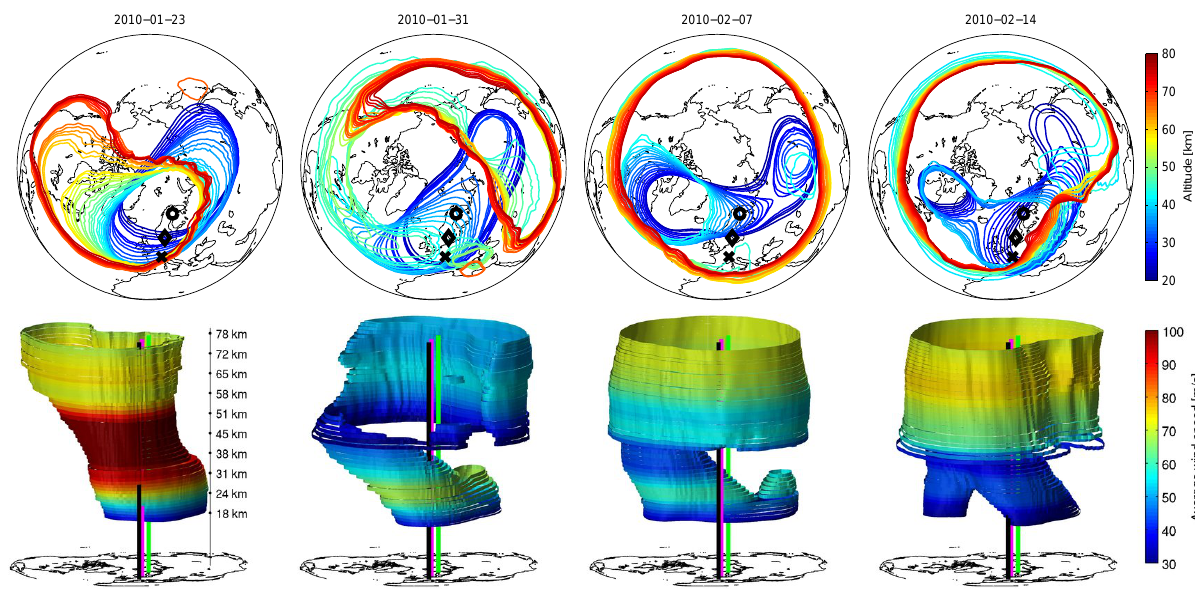
Fig. 5. Upper panel: projections of the edge of the polar vortex for 23 January, 31 January, 7 February and 14 February 2010 (from left to right). Colors indicate the geopotential height in [km]. The black cross indicates Bern, the black diamond Onsala and the black circle Sodankyl¨a. Lower panel: corresponding 3-D representation of the polar vortex. The colors indicate average wind speed [ms − 1 ] along the vortex edge. The vertical black line indicates Bern, the magenta line Onsala and the green line Sodankyl¨a.